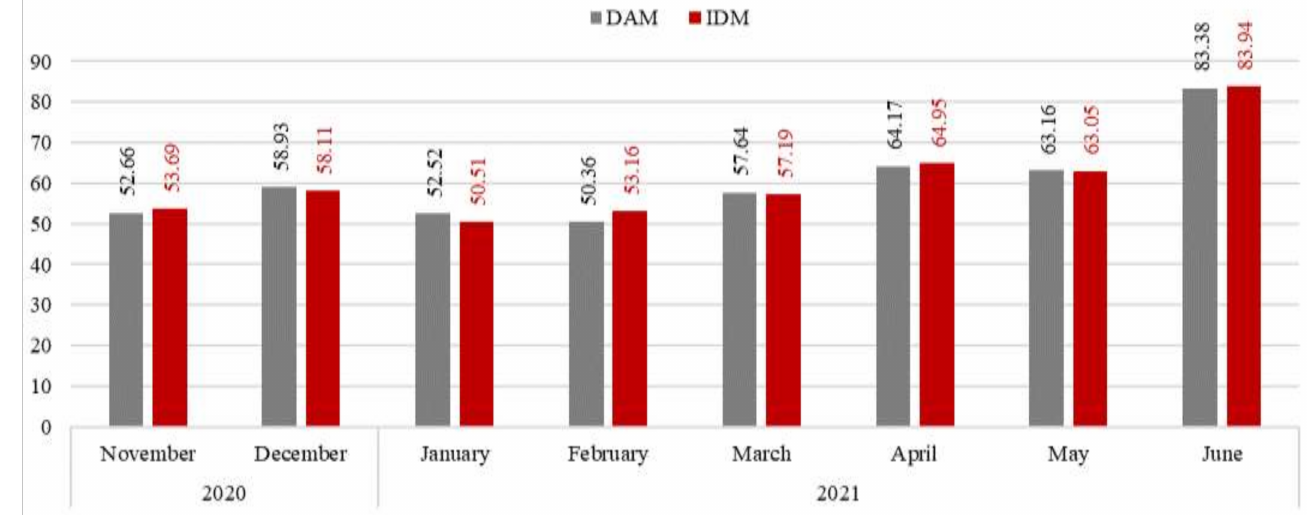
Figure 6. Day-Ahead & Intraday Prices ( € /MWh) (November 2020–June 2021), Source: Hellenic Energy Exchange and Authors’ estimations.